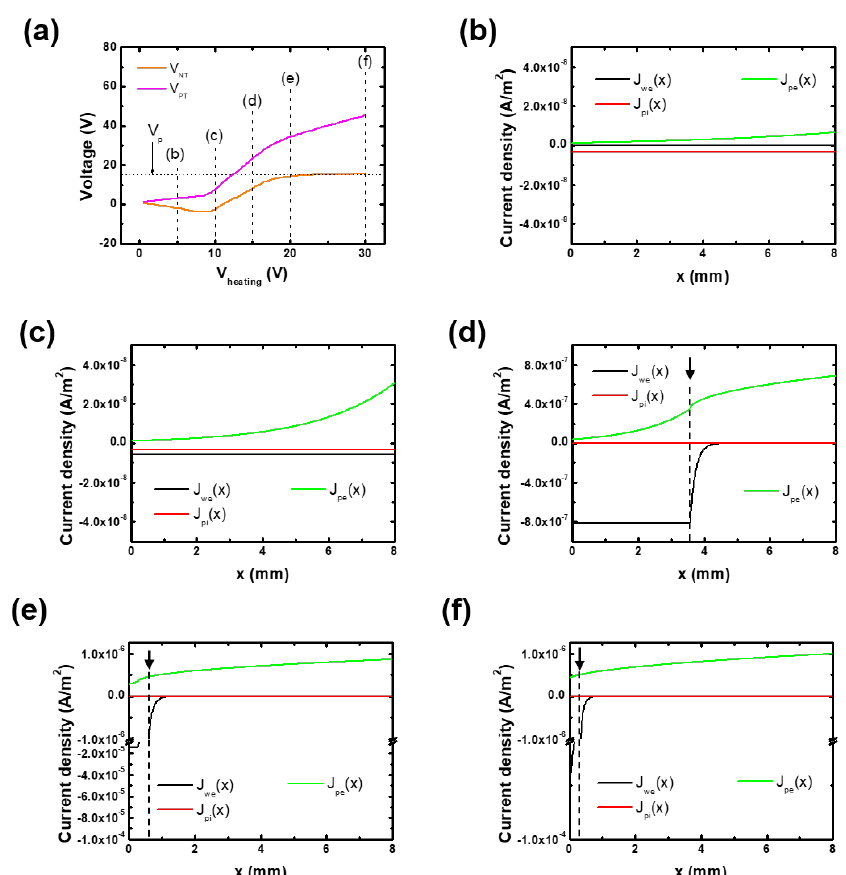
Figure 2. ( a ) Calculated negative and positive terminal voltages (V NT and V PT ) in the circuit model. The dashed line indicates the plasma potential. ( b – f ) Calculated charged particle current densi- ties over the filament wire at different heating voltages: ( b ) 5 V, ( c ) 10 V, ( d ) 15 V, ( e ) 20 V, and ( f ) 30 V. The simulation parameters were as follows: plasma potential of 15 V, electron density of 1.0 × 10 10 cm − 3 , electron temperature of 3.0 eV, filament length of 8.0 mm, filament diameter of 15 µm, and thermionic electron temperature (T w ) of 0.3